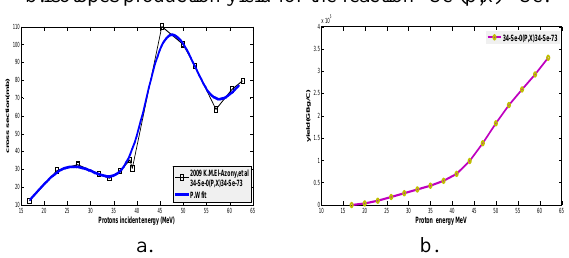
Figure 2 : a.Excitation function for the reaction 74 Se (p,x) 73 Se. b.Isotopes production yield for the reaction 74 Se (p,x) 73 Se.